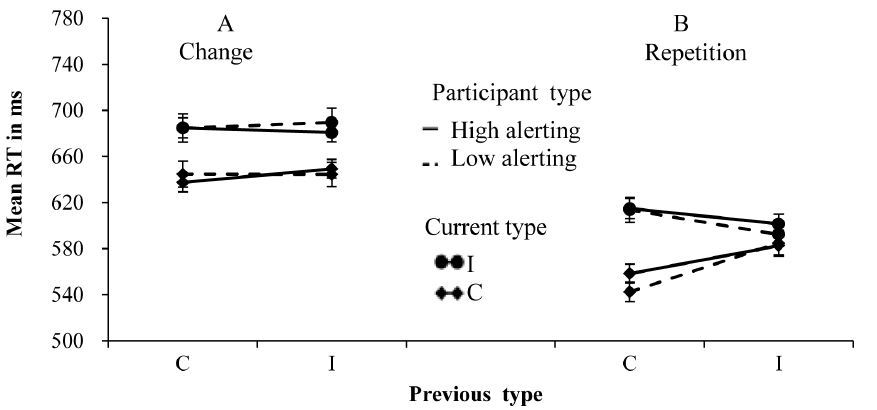
Figure 3. Mean RTs for each combination of current type and previous type in the two groups. Panel A shows the results on change trials of the high alerting level group and the low alerting level group. Panel B shows the results in the response or S-R repetition trials of the high alerting level group and the low alerting level group.